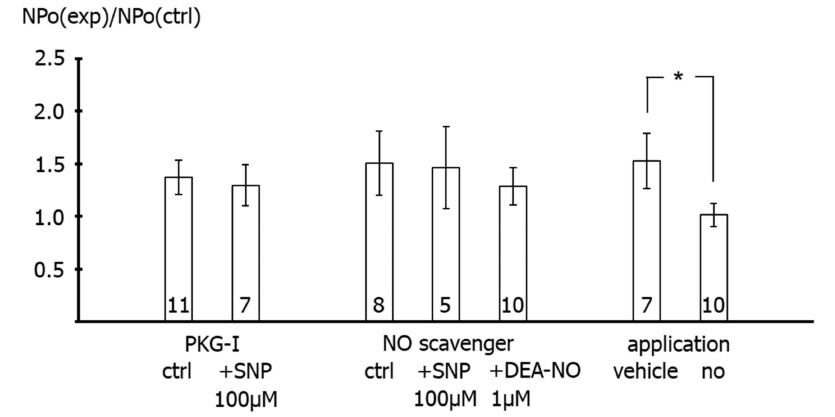
Figure 8. Effect of NO-donors on excised BK channels of rat tail artery smooth muscle cells. Data are expressed as the ratio of BK channel activity (NPo) at the end of the application period under specified experimental conditions (NPo(exp)), i.e., application of 1 µ M Rp-8-Br-PET-cGMPS alone (PKG-I ctrl) and together with SNP, 1 mM hydroxocobalamin alone (NO scavenger ctrl) and together with SNP or DEA-NO, experimental bath solution in the time control series (vehicle) and no application at all, to BK channel activity before the beginning of the application period under the same conditions (NPo(ctrl)); number of cells investigated appears on bar for each condition. *— p < 0.05. In addition, we did not detect any effect of 100 µ M MgATP ( p = 1.0), 100 µ M cGMP ( p = 1.0) or 6 U/ µ L of the catalytic subunit of PKG ( p = 1.0) on the activity of excised BK